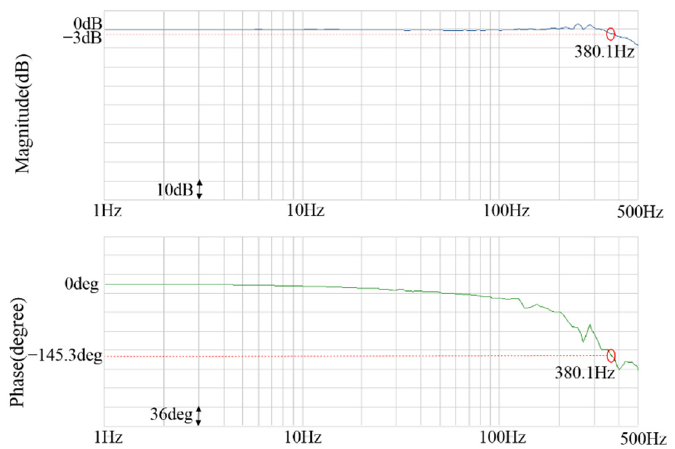
Figure 17. Bode plots of q -axis current control loop using PI controller at 2000 rpm with 4.75 Nm.